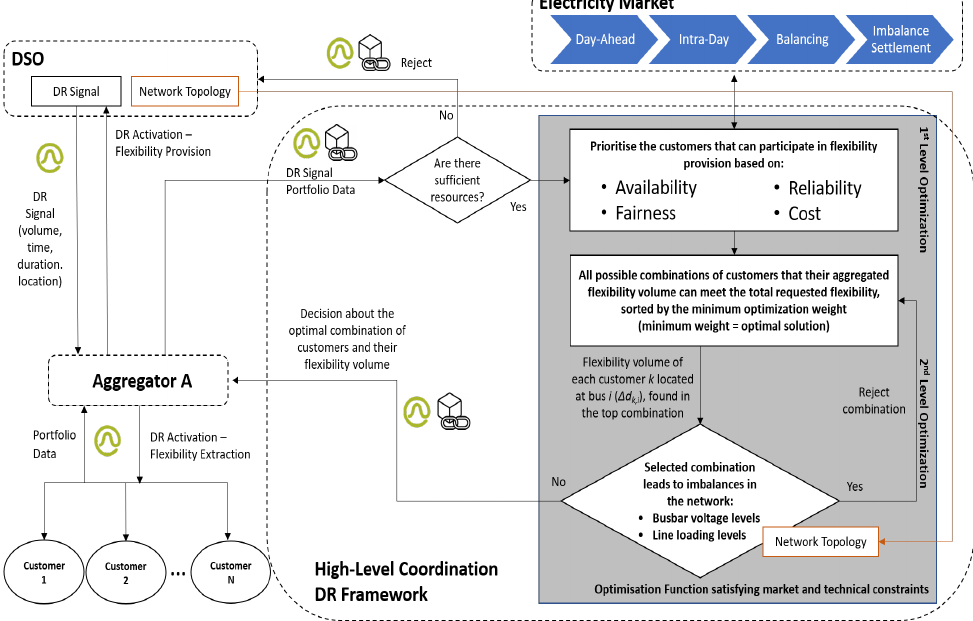
Figure 1. Decision flow diagram of the proposed DR framework for DSO-aggregator